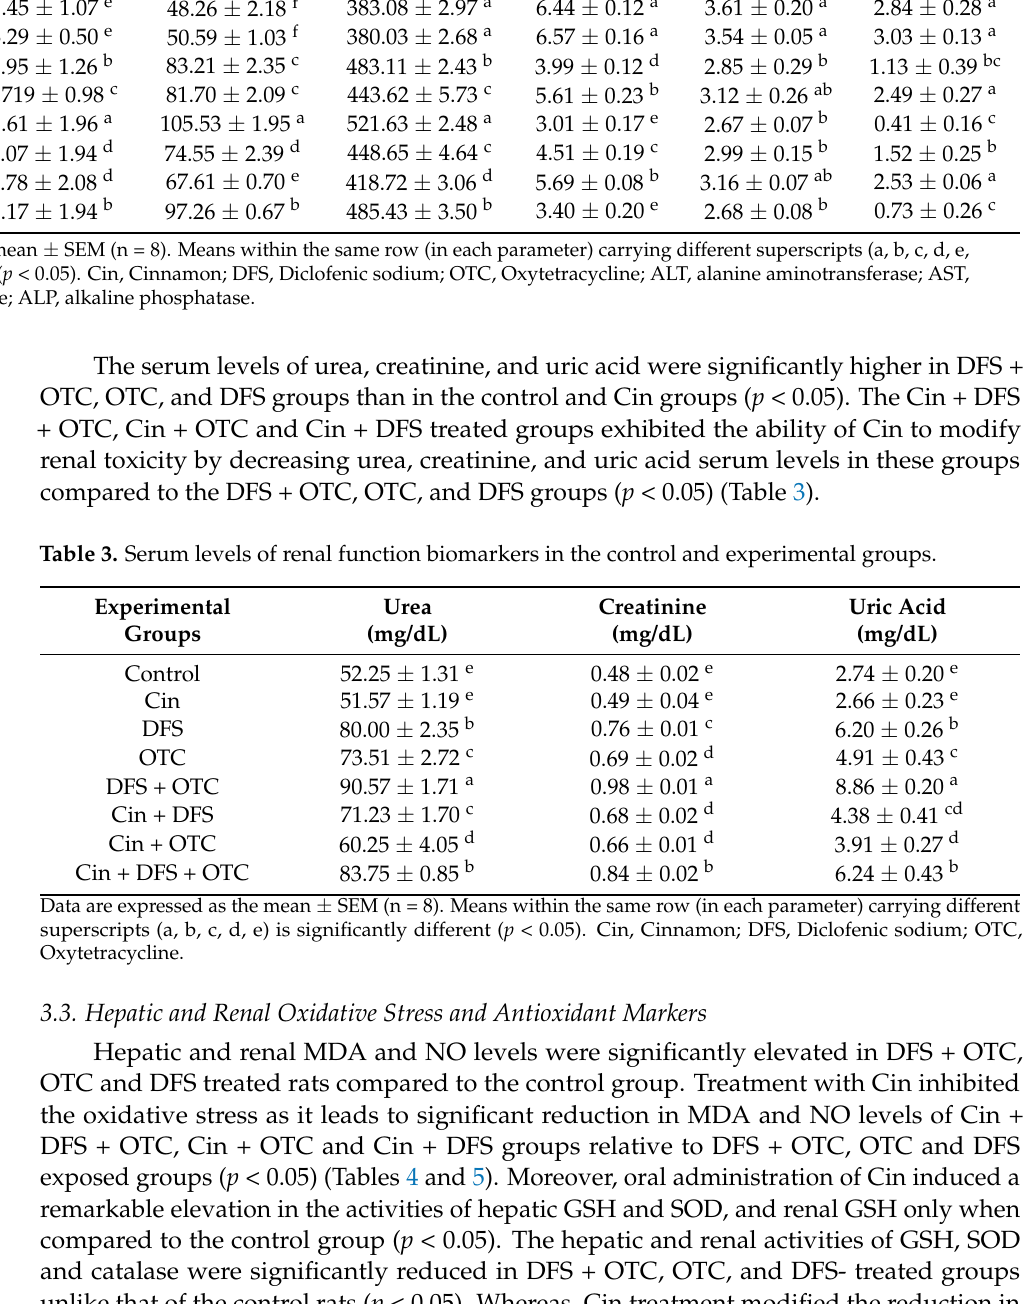
Table 2. Serum levels of hepatic function biomarkers in the control and experimental groups. Experimental Groups